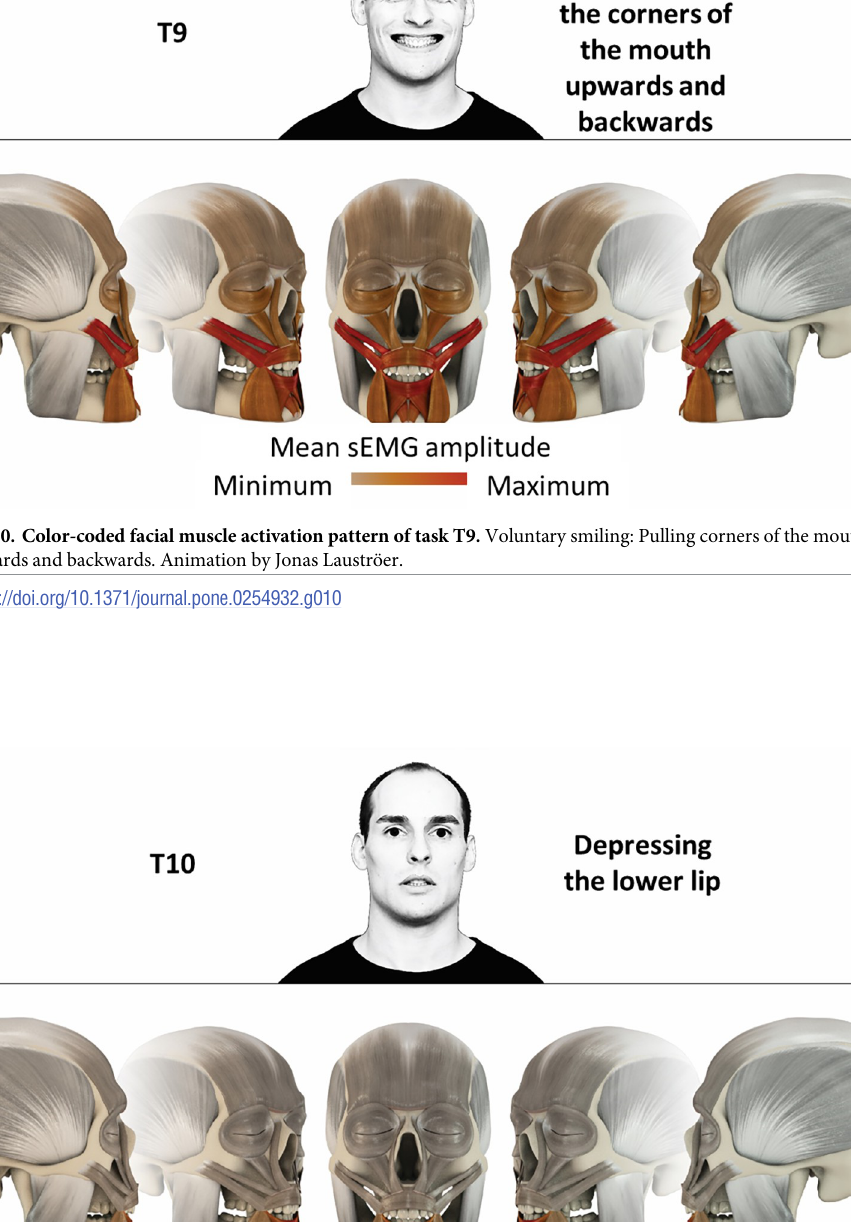
PLOS ONE | https://doi.org/10.1371/journal.pone.0254932 July 19,